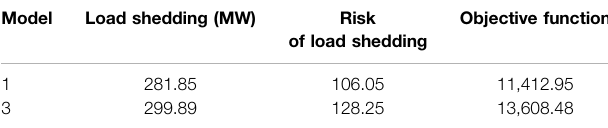
TABLE 3 | Comparison of different control models. Model Load shedding (MW) Risk